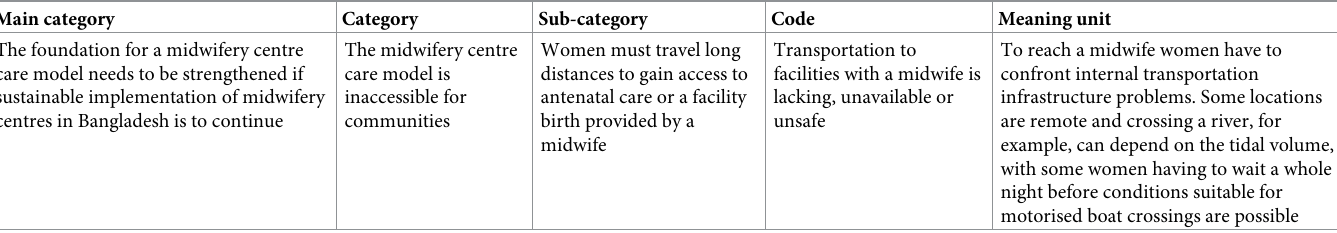
Table 1. Example of the analytical